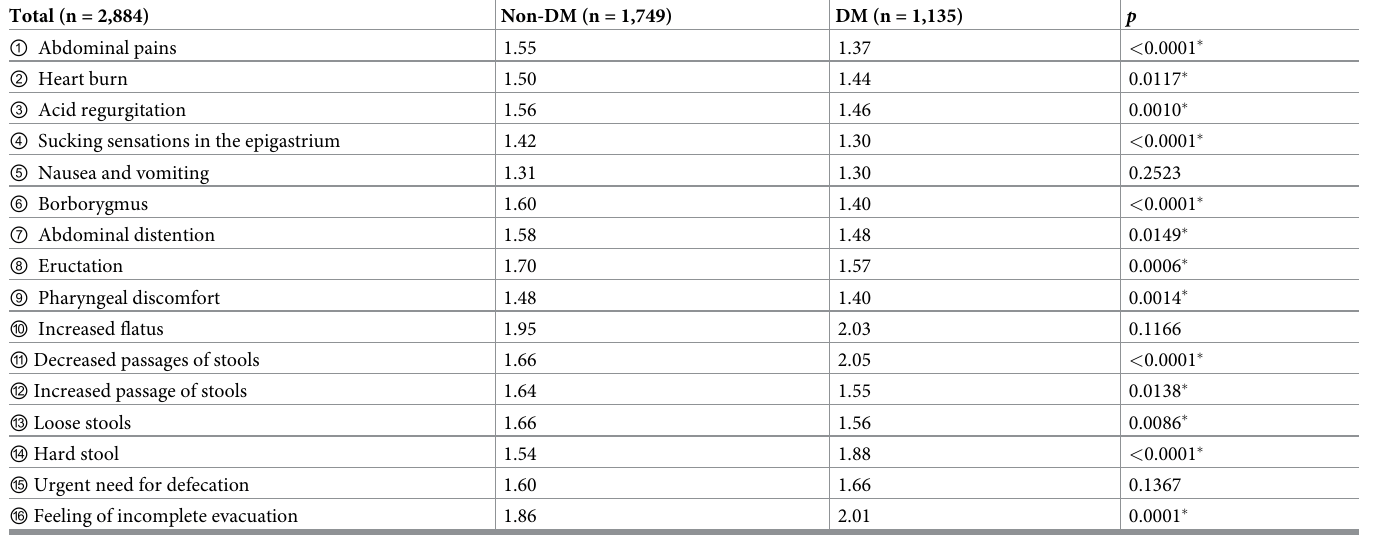
Table 2. Mean GSRS score of non-DM and DM